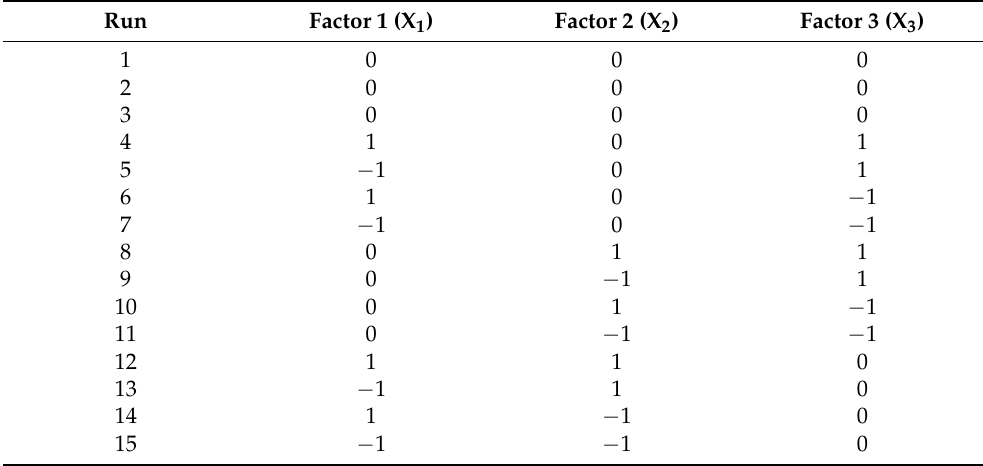
Table 1. Three factor BBD matrix, with three central points.